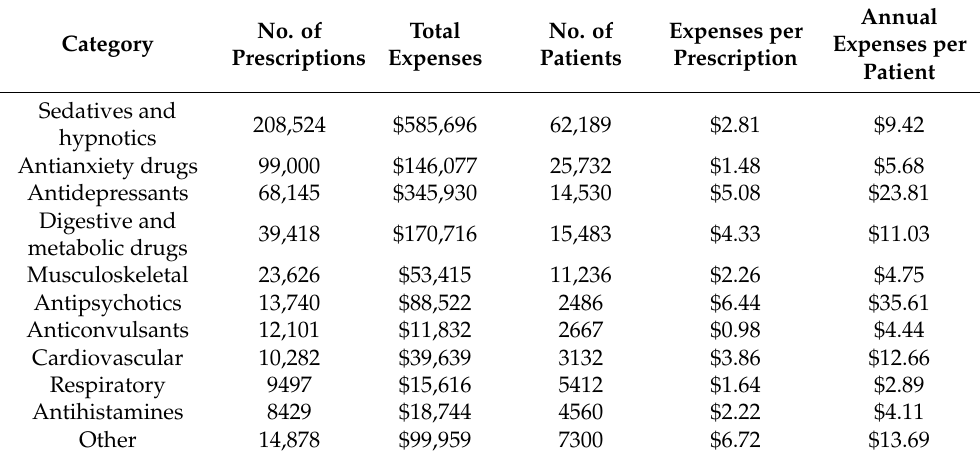
Table 4. Medications used for patients with